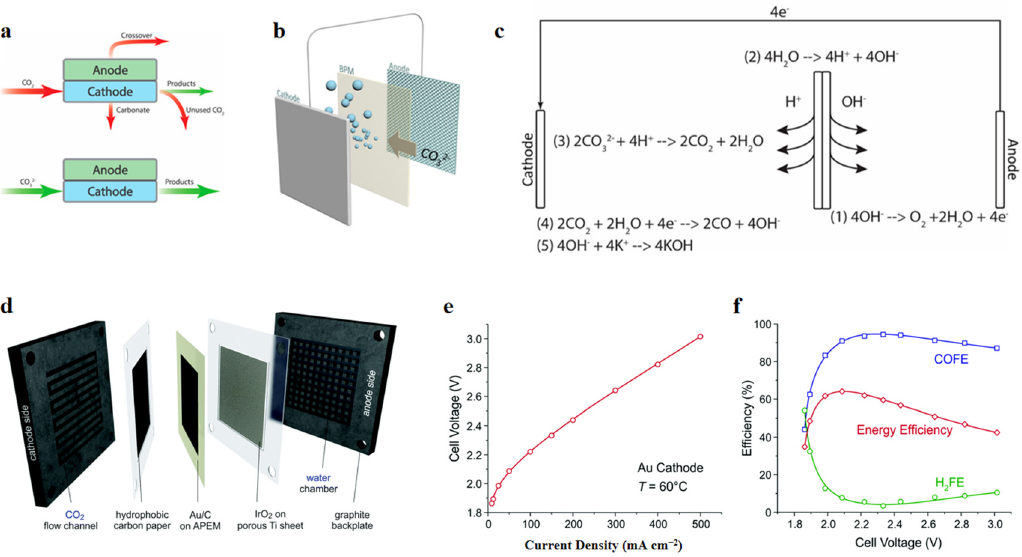
Figure 11. ( a ) Carbon loss mechanisms. ( b ) Diagram of CO 2 formation in the BPM through acid–base equilibrium reaction of H + and CO 32 − . ( c ) Reaction mechanism using CO 32 − as feed and BPM in electrolyzer. Reproduced with permission from Ref. [151]. Copyright 2019 American Chemical Society. ( d ) Schematic images of MEA using alkaline polymer electrolytes. ( e ) I–V curves for operation at 60 °C; ( f ) FEs of CO and H 2 production and energy efficiency. Reproduced with permission from Ref. [132]. Copyright 2019 The Royal Society of Chemistry.